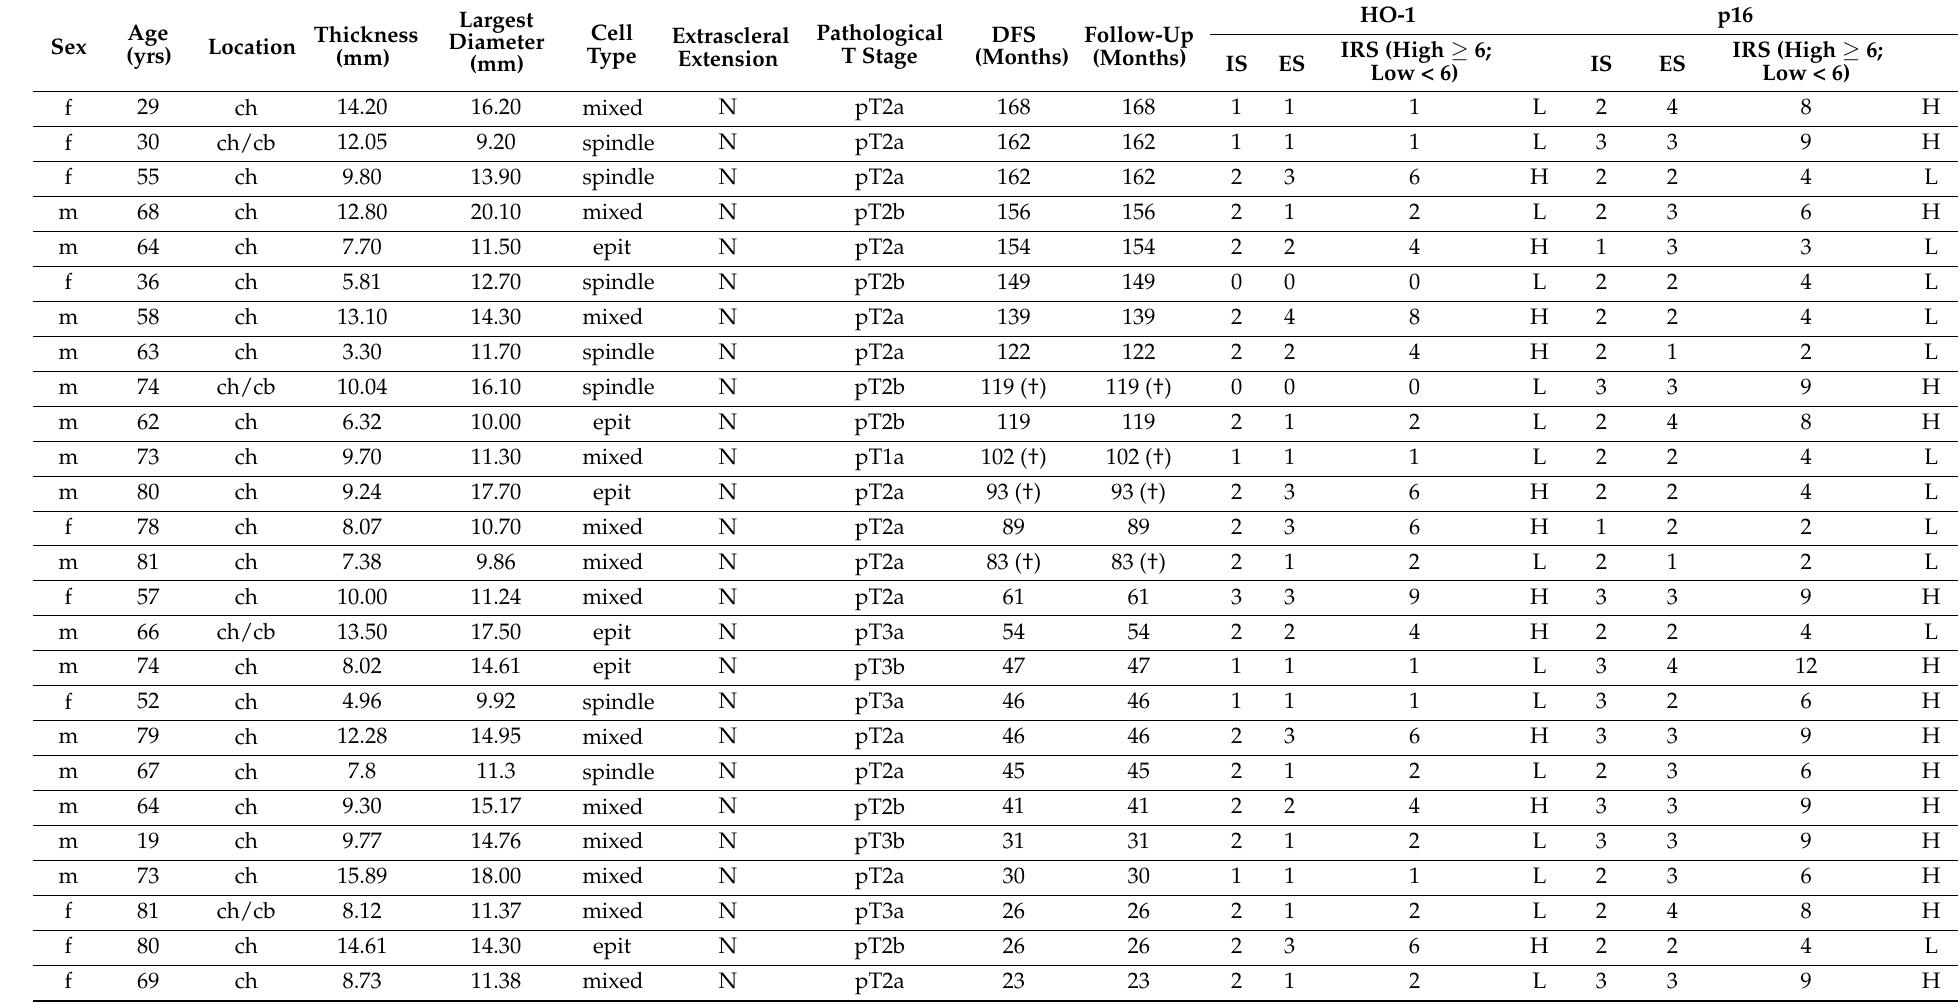
Table 2. Demographics, tumor parameters, disease-free time, follow-up, and HO-1 expression in primary uveal melanoma without metastasis (n =